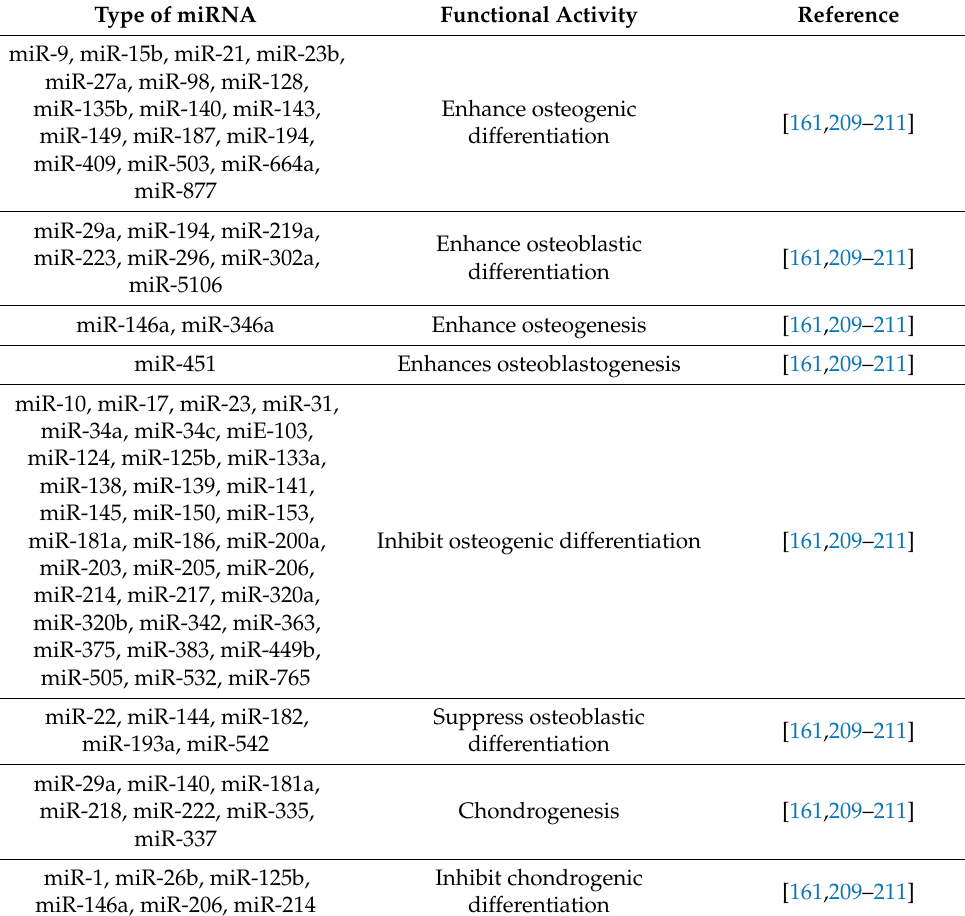
Table 4. Cont. Type of miRNA Functional Activity